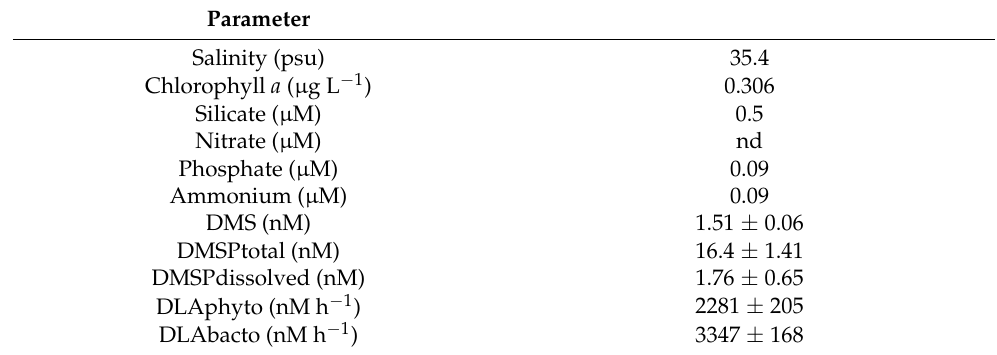
Table 1. Environmental parameters of initial seawater. Salinity, chlorophyll a, silicate, nitrate, phosphate, and ammonium concentrations at the initial sampling time point obtained by IMOS [38]. Dimethylsulfide (DMS), total DMSP (DMSPt), DMSPd, DLAb, and DLAp concentrations of the initial seawater.